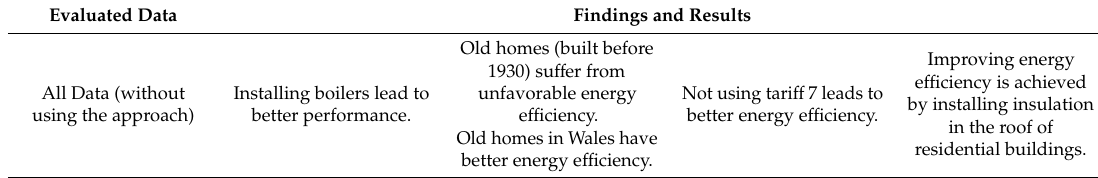
Table 7. Assessing the results of the proposed